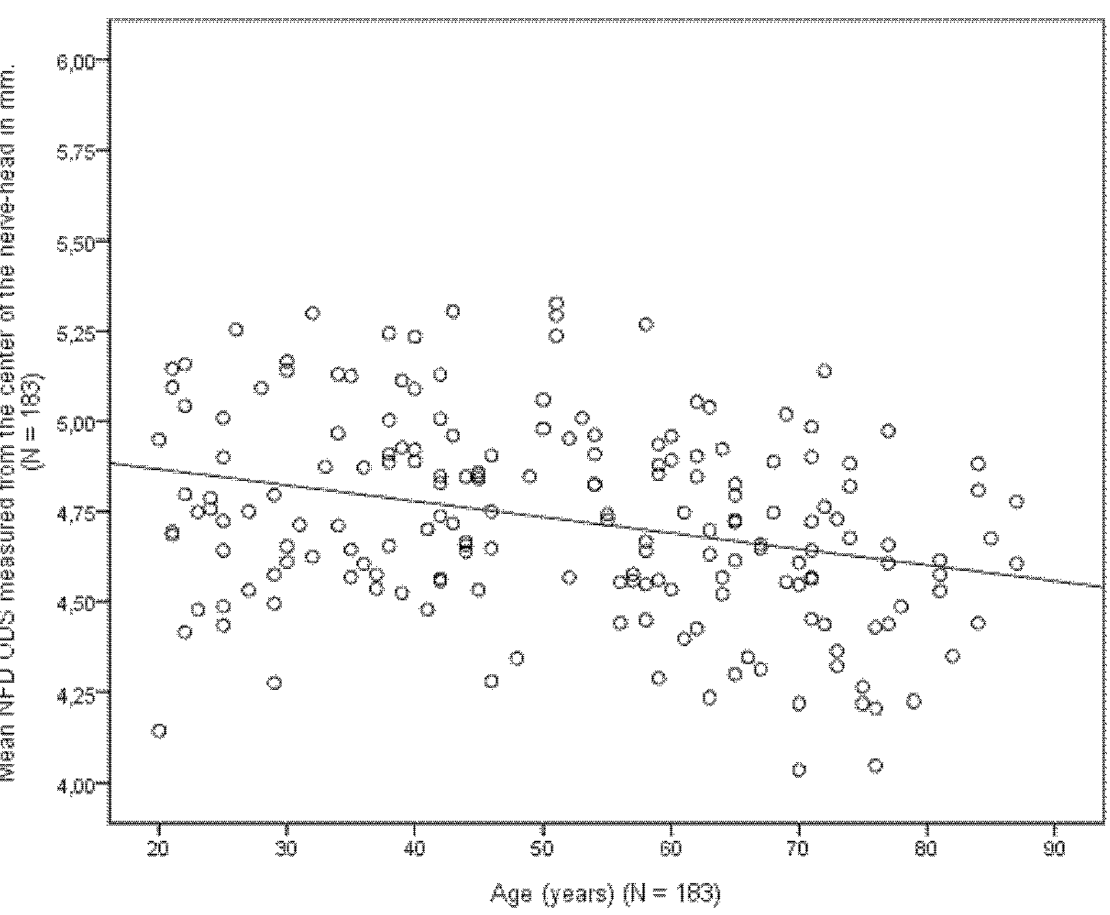
Figure 5. The age of 183 patients plotted against the mean NFD measured form the center of the nerve-head of both eyes (ODS) together with the line of equation (N=183). doi:10.1371/journal.pone.0062518.g005 NFD. When measured from the center of the nerve-head, we found that NFD decreased by 0.062 mm (P , 0.001) per unit